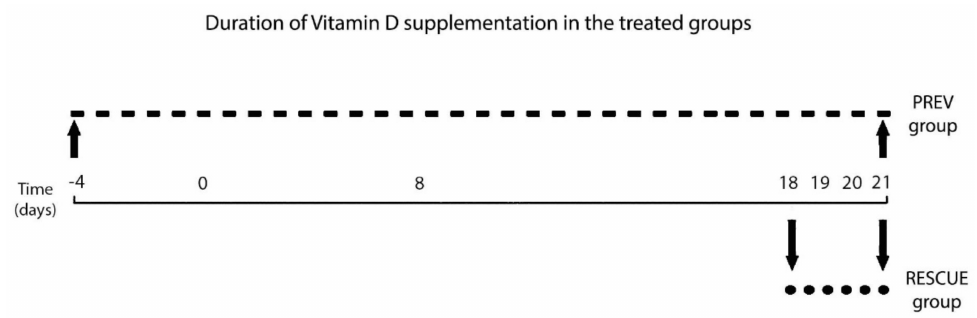
Figure 8. Timeline of VD treatment in the PREV and RESCUE